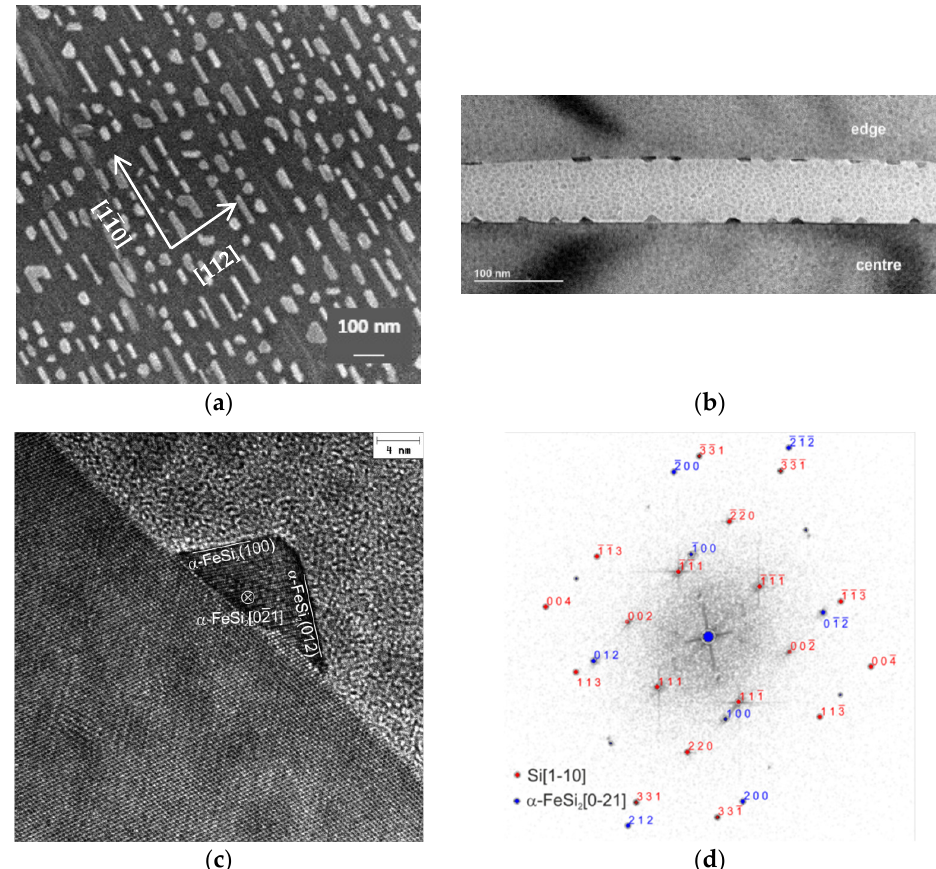
Figure 2. TEM (planar) and HRTEM on cross section images of Fe silicide/Si interfaces: ( a ) general view of two glued samples; ( b ) cross section of Fe silicide NR with its main facets and direction [021]; [0 2(cid:3364) 1]; ( d ) FFT pattern from areas ( c ) with identification of α -FeSi 2 planes.